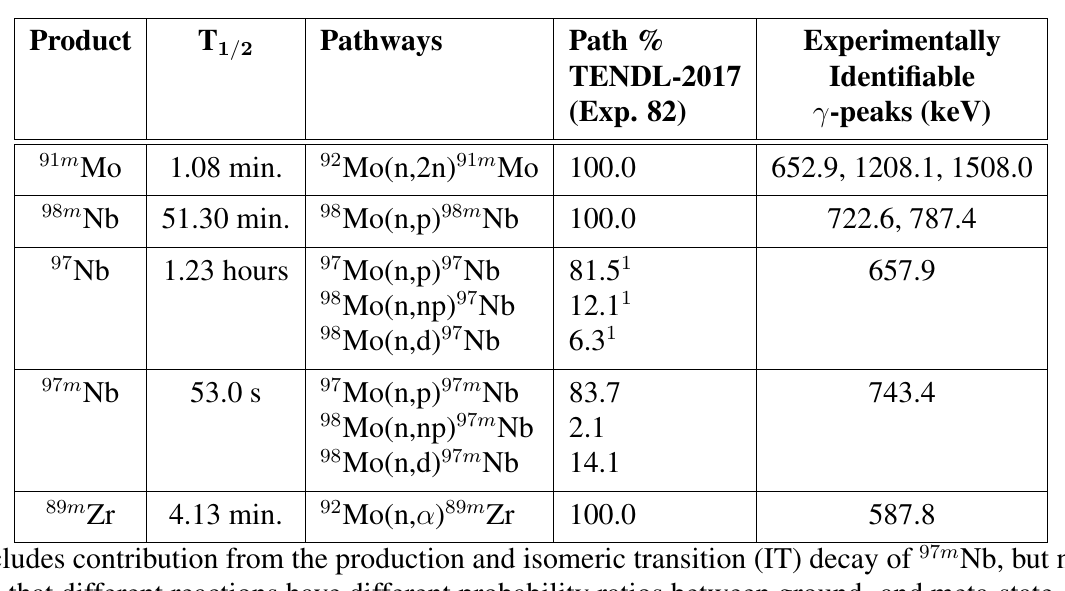
Table 1: Information about the radionuclides measured in the ASP experiments. The FISPACT-II-calculated production pathways and their % contributions were obtained from the simulations with the TENDL-2017 library (see the main text). Only the γ -peak energies observed in the experiments are listed for each